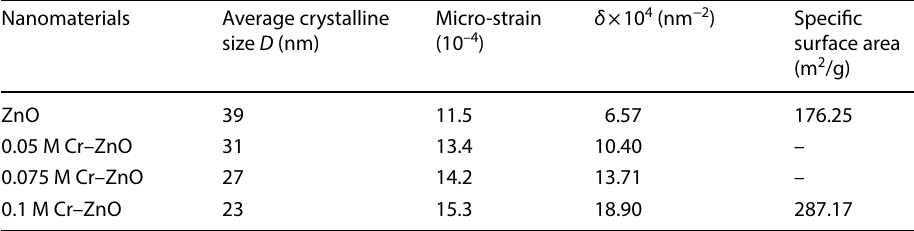
Table 1 XRD parameter and specific surface area values of un-doped ZnO and Cr-doped ZnO